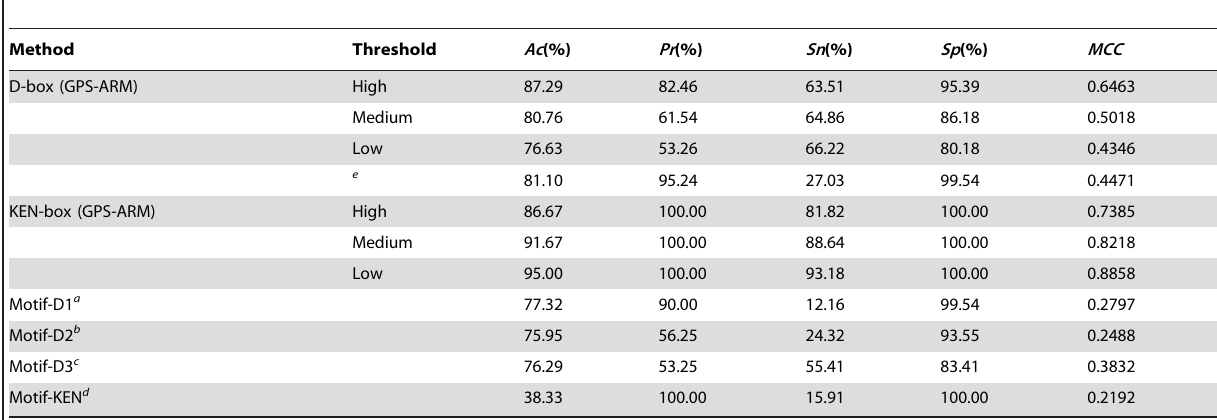
Table 1. Performance evaluation and comparison of the GPS-ARM with known